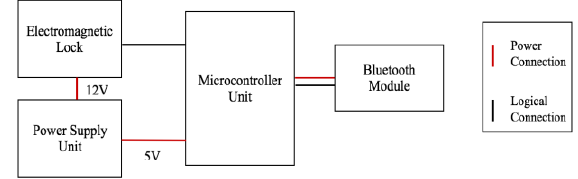
Fig. 9. Block Diagram of the Hardware Subsystem showing end-end implementation